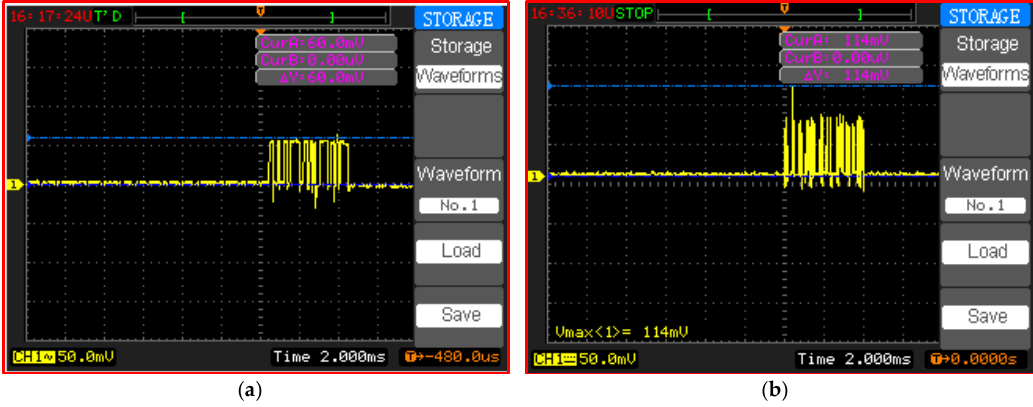
Figure 10. Active current consumption using a storage oscilloscope (DQ7042C) for ( a ) the Atmega328p microcontroller and ( b ) XBee S2C.